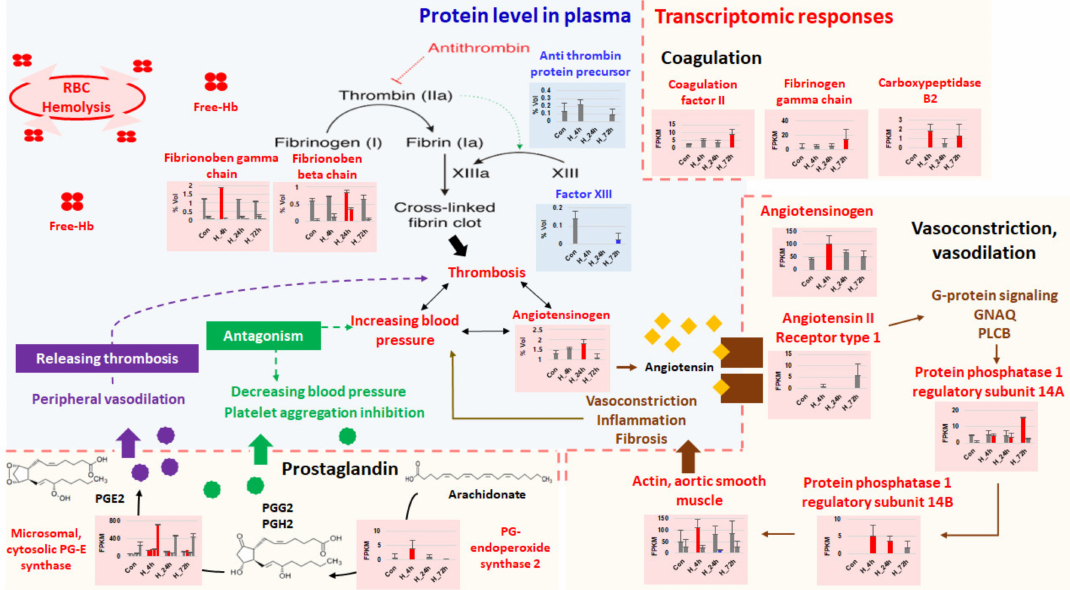
Figure 9. Schematic diagram showing genes and proteins necessary for thrombosis and modulation of vasoconstriction and vasodilation during thermal